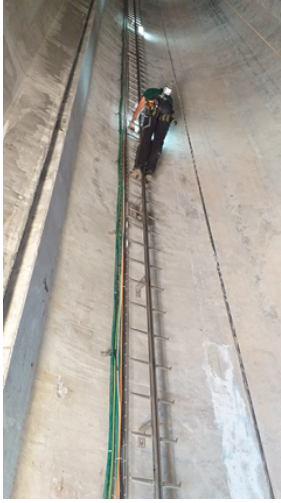
Figure 21. Mobile sensor node going up inside the ELICAN